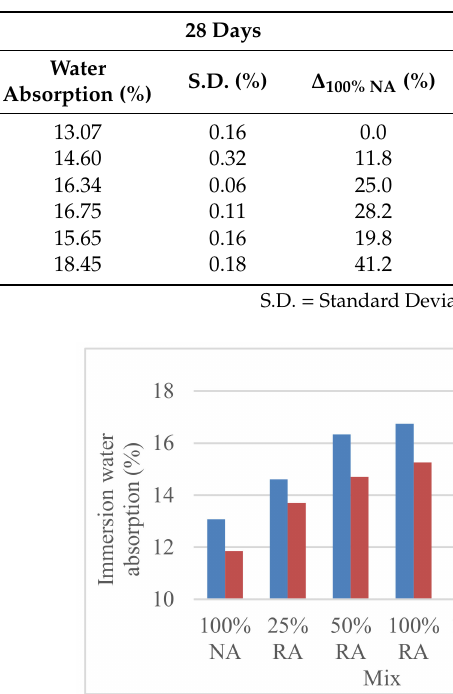
Table 4. Immersion water absorption results at 28 and 91 days.